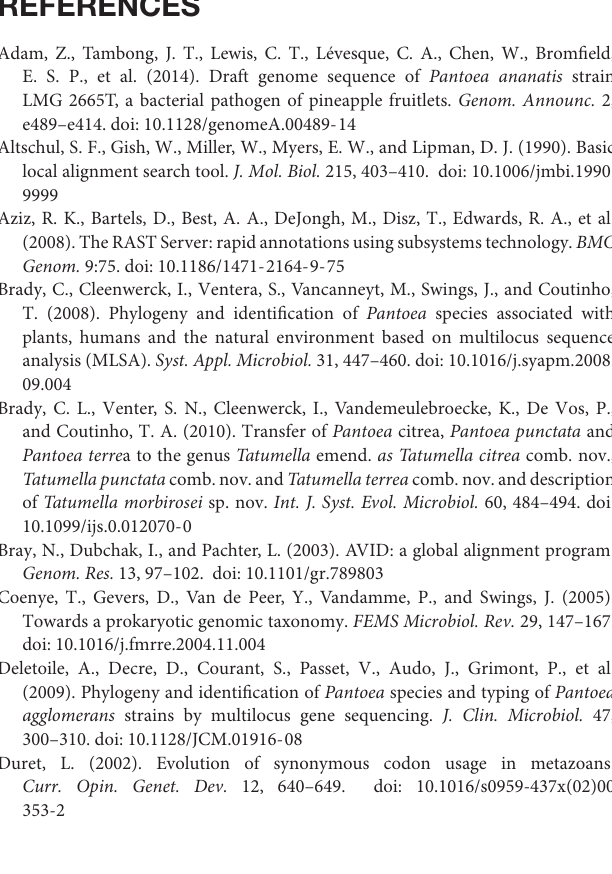
FIGURE S1 | UGPMA Dendrogram generated using PermutMatrix showing two clusters: (A) genomes correctly identified as P. vagans , and (B) incorrect species-level assignment. 1, leu S; 2, MLSA; 3, Average nucleotide identity (ANI); 4, MuMmer-based ANIm; 5, Tetranucleotide patterns; and 6, genome-based DNA-DNA hybridization (gDDH). P. vagans C9-1 is used as a reference. ∗ Genome sequences had two copies of each of the genes (double the size of average Pantoea genome) which might have affected the genome-based DDH values. ∗∗ CP011427 could be a putative novel species with Pantoea rodasii as the closest relative.